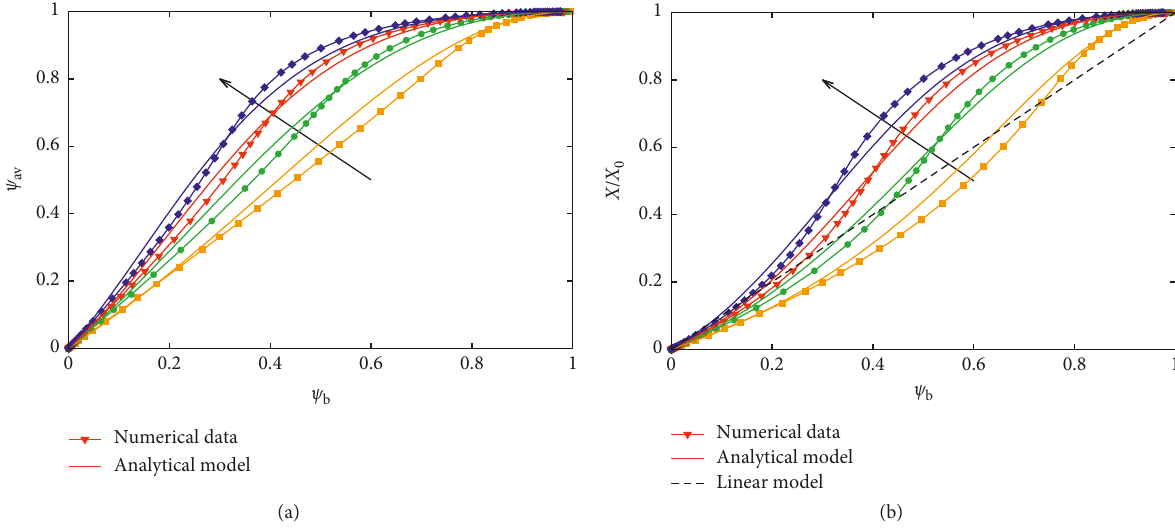
T T from the analytical approach and D 4th from the shortcut numerical approach. Continuous line ( ) ( ) 6 (m 2 /s) and E / R T D E / RT with D 4th 1 . 28 10 0 exp [ 0 (cid:31) ( ) (cid:31) ( )] × − −